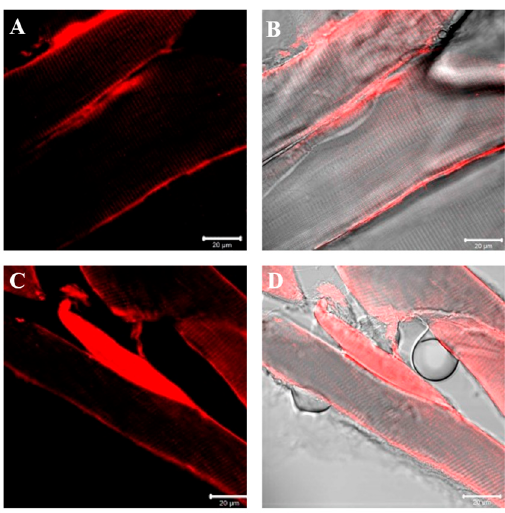
Figure 7. Compound panel of single immunofluorescence reaction using anti-laminin antibody in sternocleidomastoid muscle of high-ranking ( A , B ) and low-ranking ( C , D ) baboons. Laminin fluo- rescence pattern (red channel) is distributed around all muscle fibers of both ranking classes, at basal lamina level as evidenced by transmitted light ( B , D ).